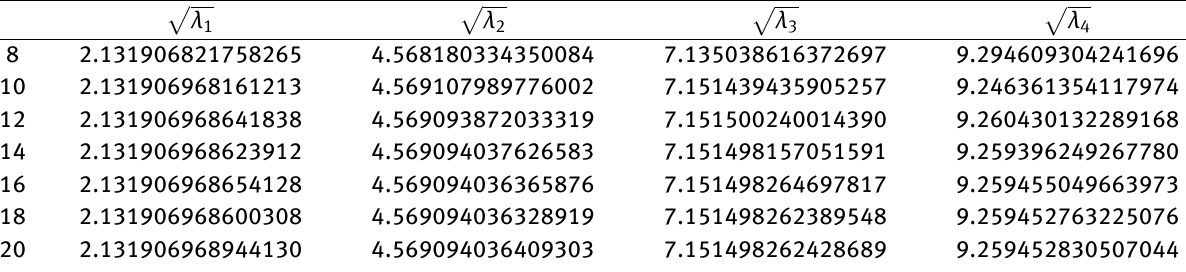
(︁ √ )︁ for CF case for different grid λ